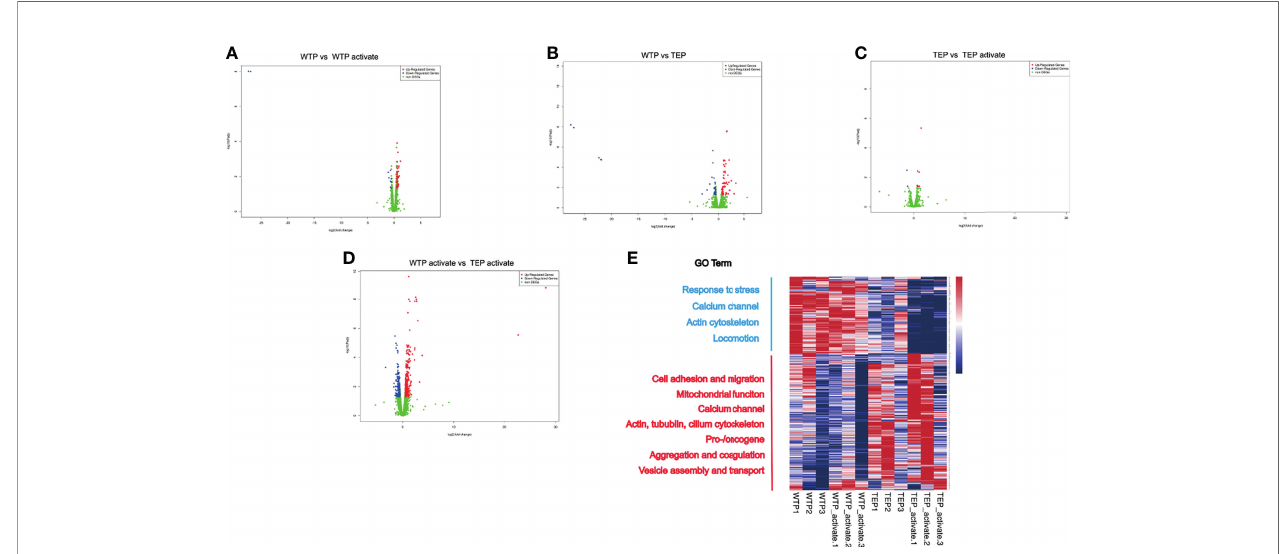
FIGURE 3 | The RNA sequence pro fi le of tumor-educated platelets. (A) Once WTPs were activated, there were in all 54 genes upregulated and 11 genes downregulated compared to their inactivated state. (B) Compared to WTP, there were 66 genes upregulated and 39 downregulated in TEP. (C) Only 13 genes were upregulated and two downregulated in active TEPs compared to inactivated TEPs. (D) Relative to the activated WTPs, there were 358 upregulated and 203 downregulated genes in the activated TEPs. (E) The heatmap of the RNA transcript. The genes in WTPs and activated WTPs enriched mainly in genes associated with response to stress, calcium channel, actin cytoskeleton, and locomotion. In TEPs and activated TEPs, the differential genes enriched in cell adhesion and migration, mitochondrial function, calcium channel, actin, cilium cytoskeleton, pro-/oncogene, aggregation, and coagulation, vesicle assembly, and transport. GO, gene ontology; DEG, differential expression gene; WTP, wild-type platelet; TEP, tumor-educated